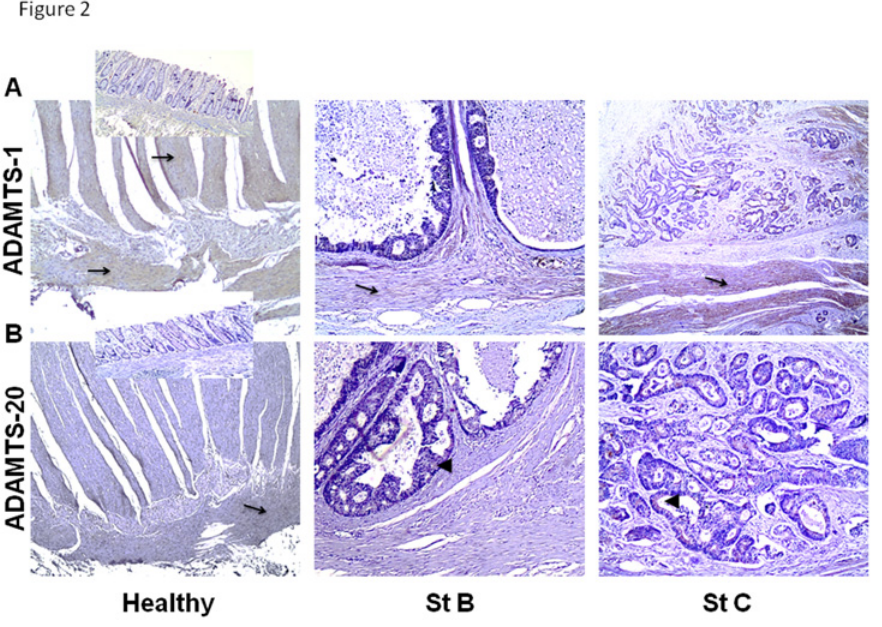
20 (B). (A, magnification; x4, anatomic site; cecum, magnification; x4, anatomic site; cecum, magnification; x4, anatomic site; rectum and B, magnification; x4, anatomic site; cecum, magnification; x20, anatomic site; cecum, magnification; x20, anatomic site; rectum). Insets of A and B (magnification of all; x10) show the Mucosa and the Submucosa layer. Arrows in healthy colon show the expression of ADAMTS in the muscle tissue. Arrows in cancerous colon show the expression of ADAMTS in stroma, while arrowheads show the expression of ADAMTS in cancer cells.